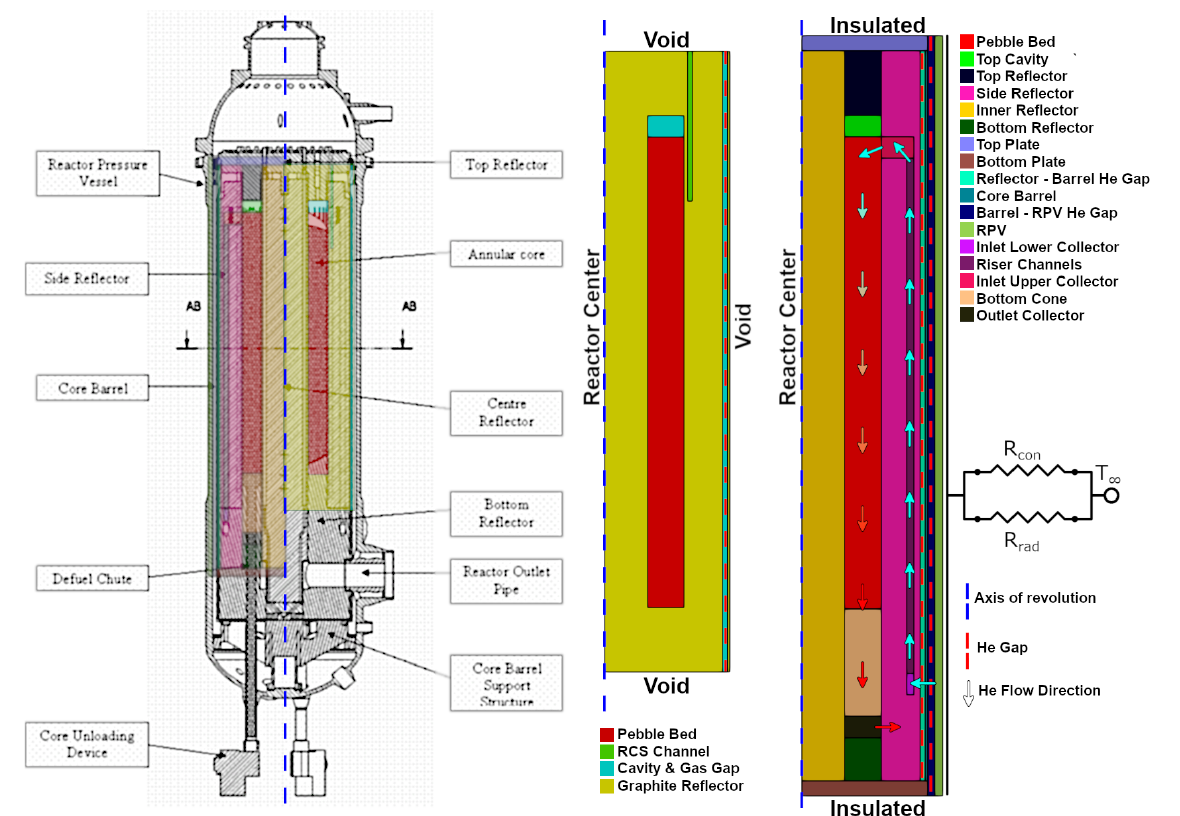
Figure 1: PBRM-400 Modeling Approach and r-z